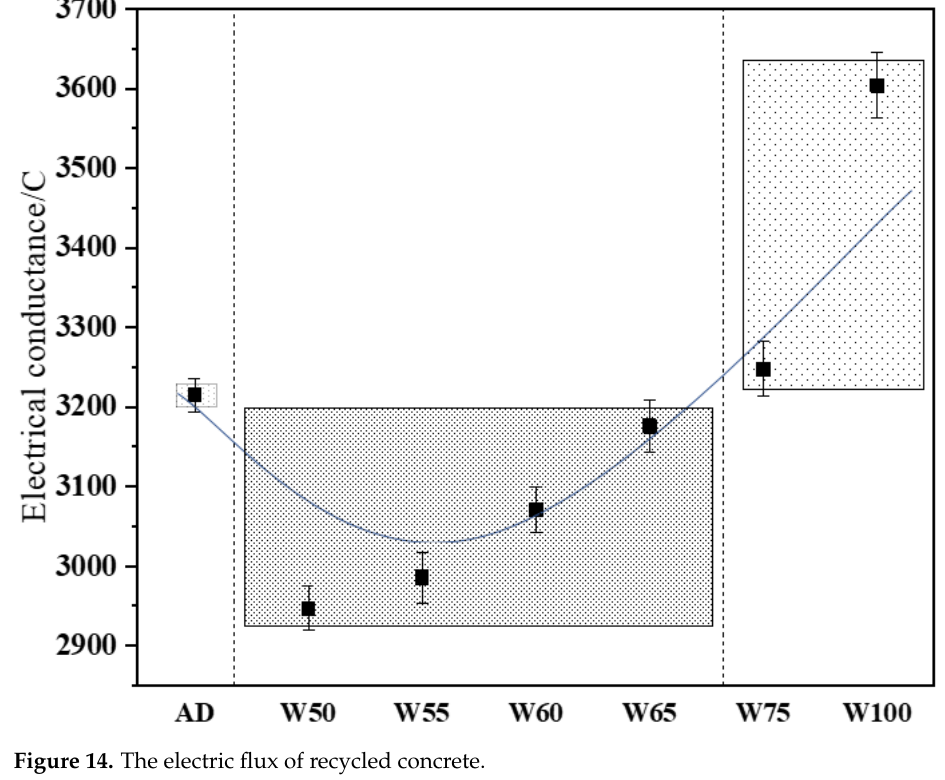
Figure 14. The electric flux of recycled concrete.